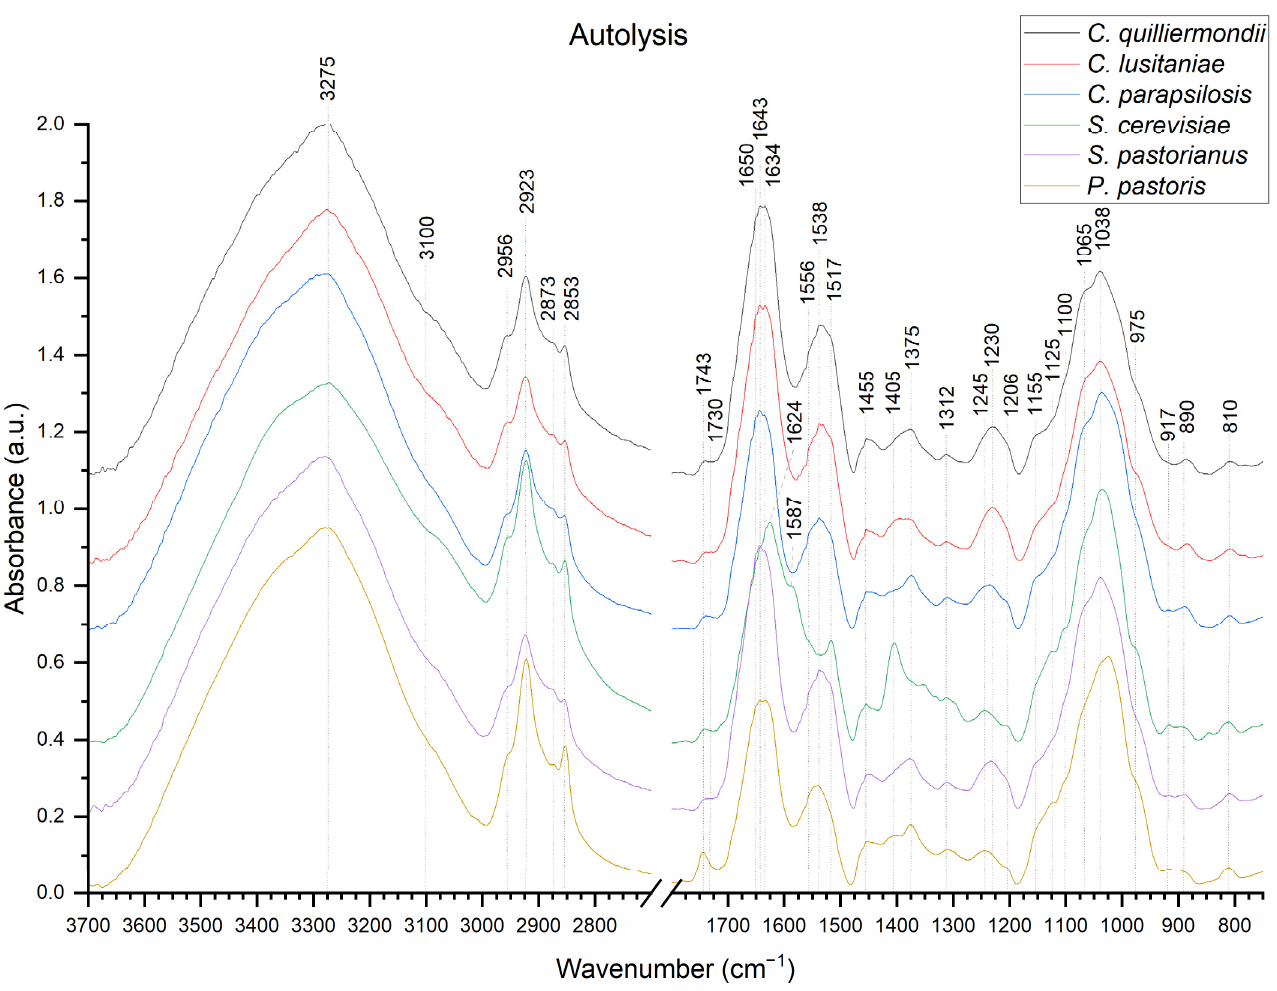
Figure 2. ATR IR absorption spectra of autolyzed cells of different yeast strains: (from top to bottom) C. guilliermondii , C . lusitaniae , C . parapsilosis , P. pastoris , S. cerevisiae and S . pastorianus.